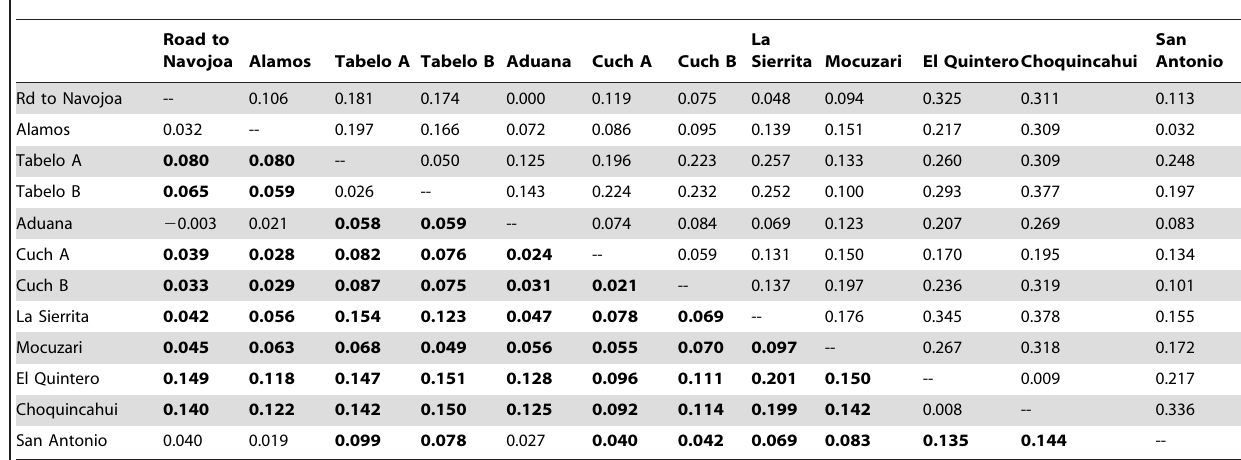
Table 2. Pairwise genetic differentiation between populations estimated from 10 microsatellite loci.